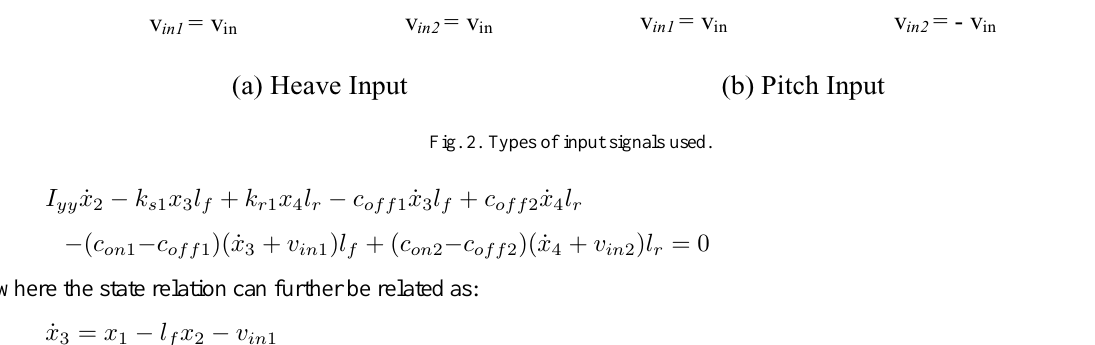
Fig. 2. Types of input signals